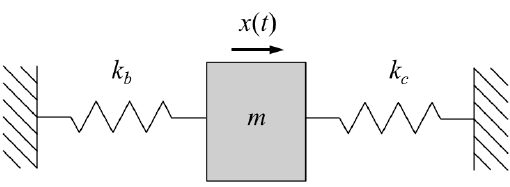
Figure 3. Simple, equivalent mechanical model of the piezoelectric actuator.